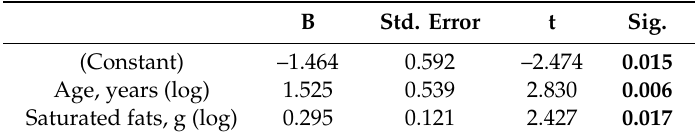
Table 7. Multivariable model predicting HOMA-IR, F (2, 90) = 7.433, p = 0.001, adj. R 2 = 0.123. p -values ≤ 0.050 are shown in bold.